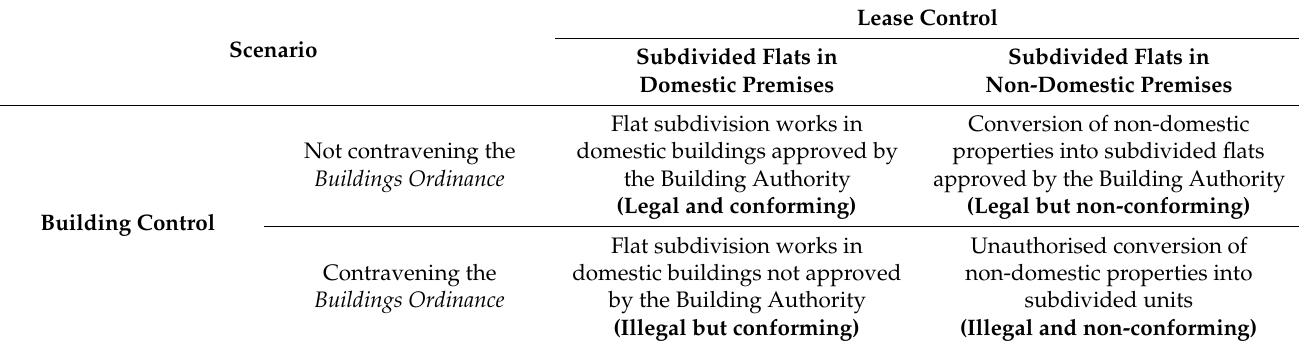
Table 2. Informality of Subdivided Units under Hong Kong’s Lease and Building Control System in Hong